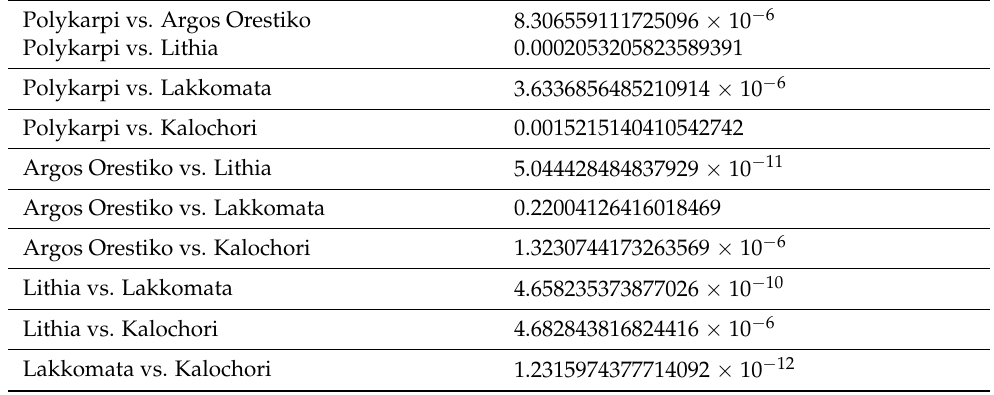
Table A1. p -values of Freeman-Halton exact test based on the above contingency tables.